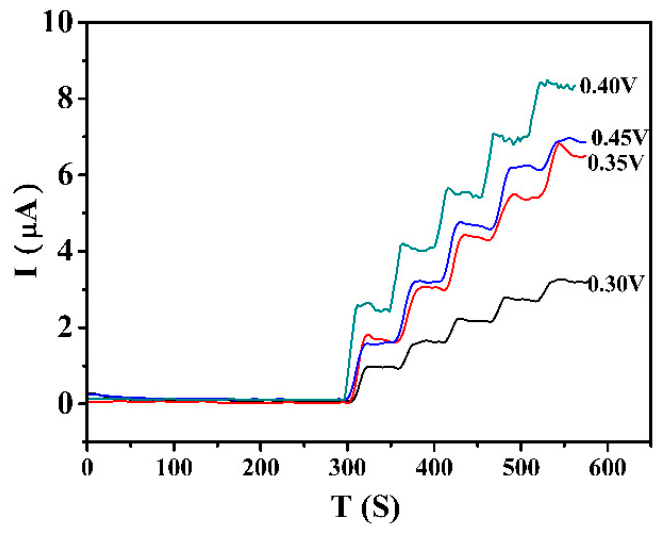
Figure 8. I-T plots of AuNPs@COFs/GCE to ractopamine at different potentials in 0.1 mol/L PBS solution.